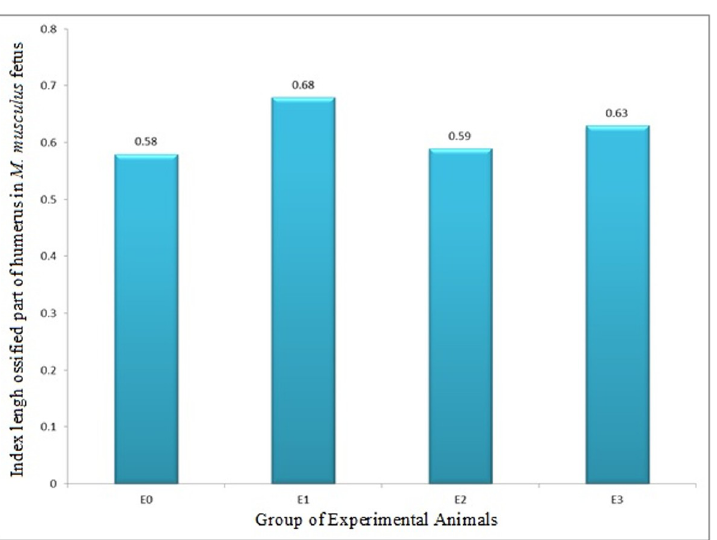
kg bw HgCl 2 on GD 9 (E2), and administered 5 mg/kg bw HgCl 2 on GD 9 and then 0.39 mg/g bw LE3H on GD 10 (E3). Meanwhile, the controls (E0) were administered double-distilled water only.